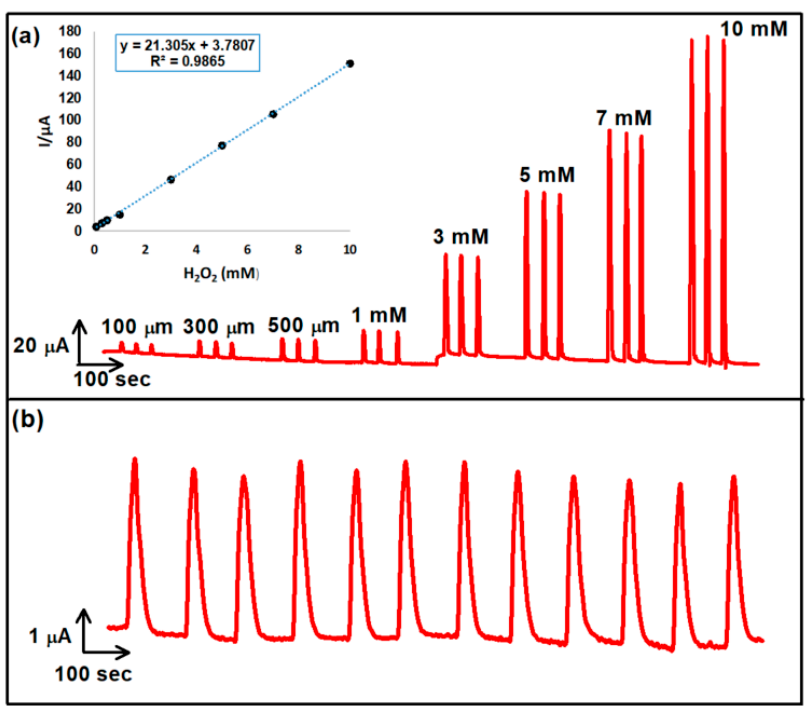
Figure 7. ( a ) Detection of H 2 O 2 by FIA method at SPCE/NPC 600 , ( b ) FIA responses of 12 continuous injections of 0.5 mM H 2 O 2 .